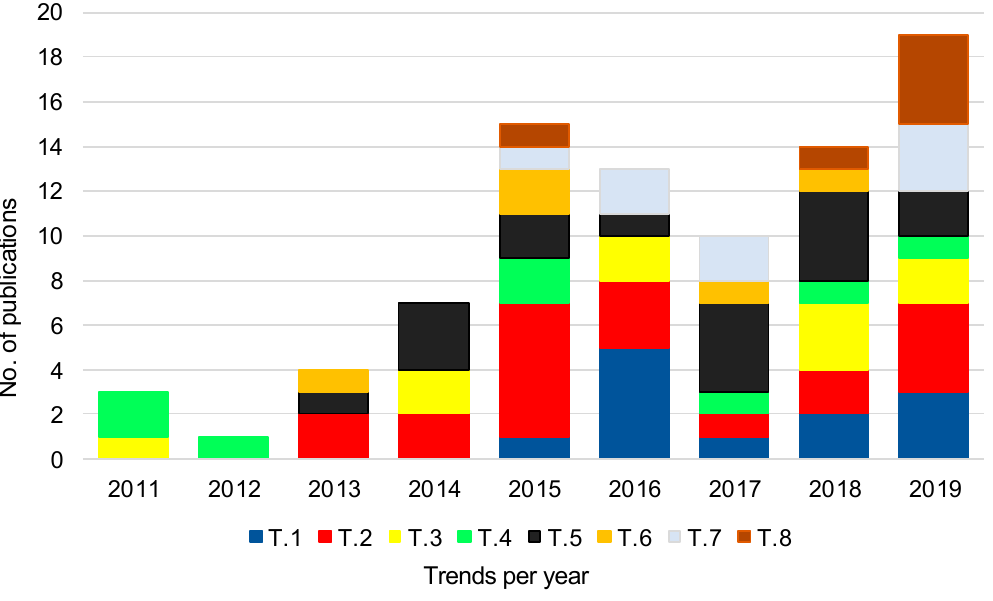
Figure 5. Research targets of publications per year from 2011-2019.